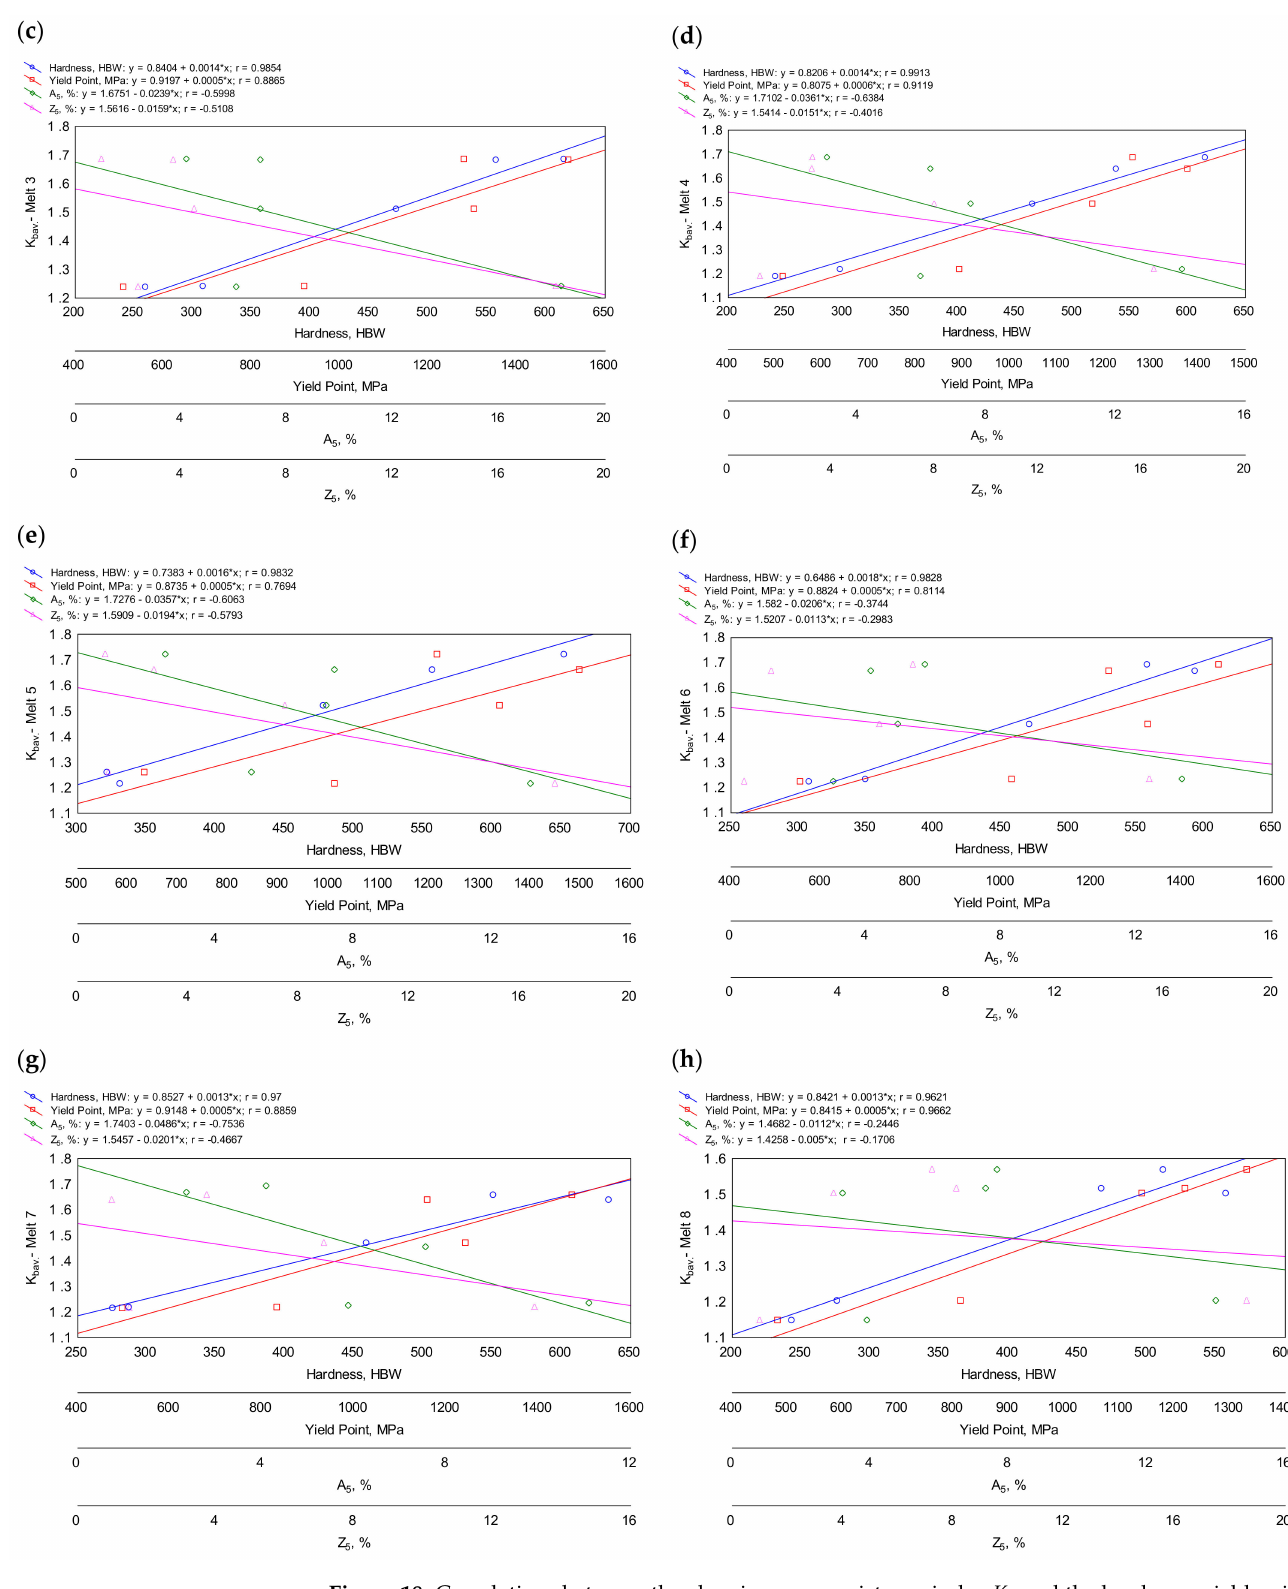
Figure 18. Correlations between the abrasive wear resistance index K b and the hardness, yield point, elongation and area reduction after fracture of the ingots in all the analyzed states (as-cast, quenched, quenched and tempered at 200, 400 and 600 ◦ C): ( a ) ingot No. 1; ( b ) ingot No. 2; ( c ) ingot No. 3; ( d ) ingot No. 4; ( e ) ingot No. 5; ( f ) ingot No. 6; ( g ) ingot No. 7; ( h ) ingot No.